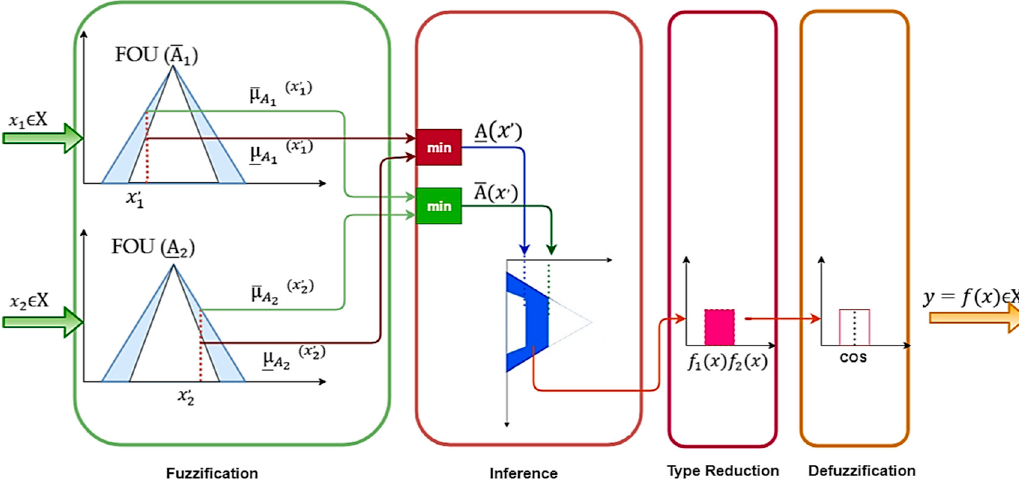
Figure 8. Structure of a type-2 fuzzy logic system.